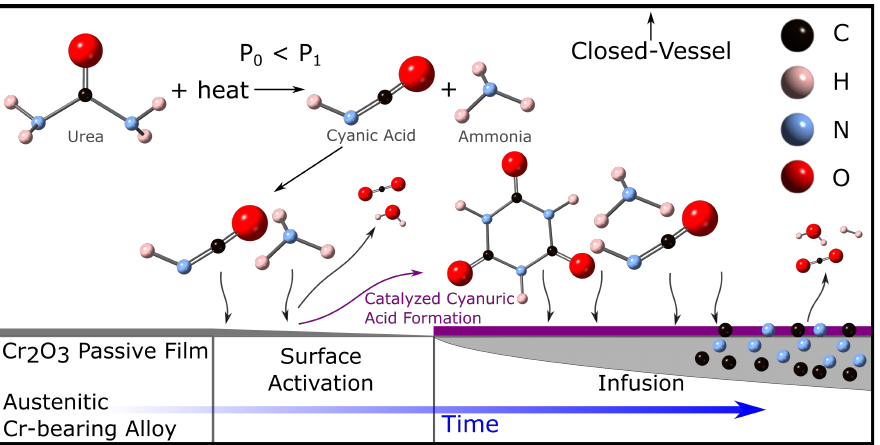
Figure 11. Model for surface engineering of Cr-bearing alloys by solid-reagent pyrolysis in a closed- vessel. (For clarity, minor reactions and species not